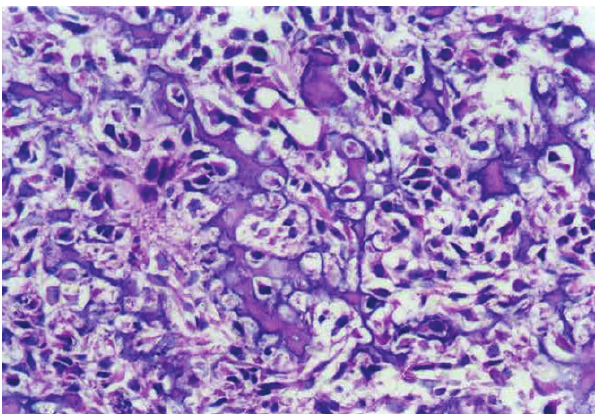
Figure 4 - Atypical osteoblastoma. Focal areas of fine, lace-like osteoid (Case 29, hematoxylin-eosin stain, X 400)